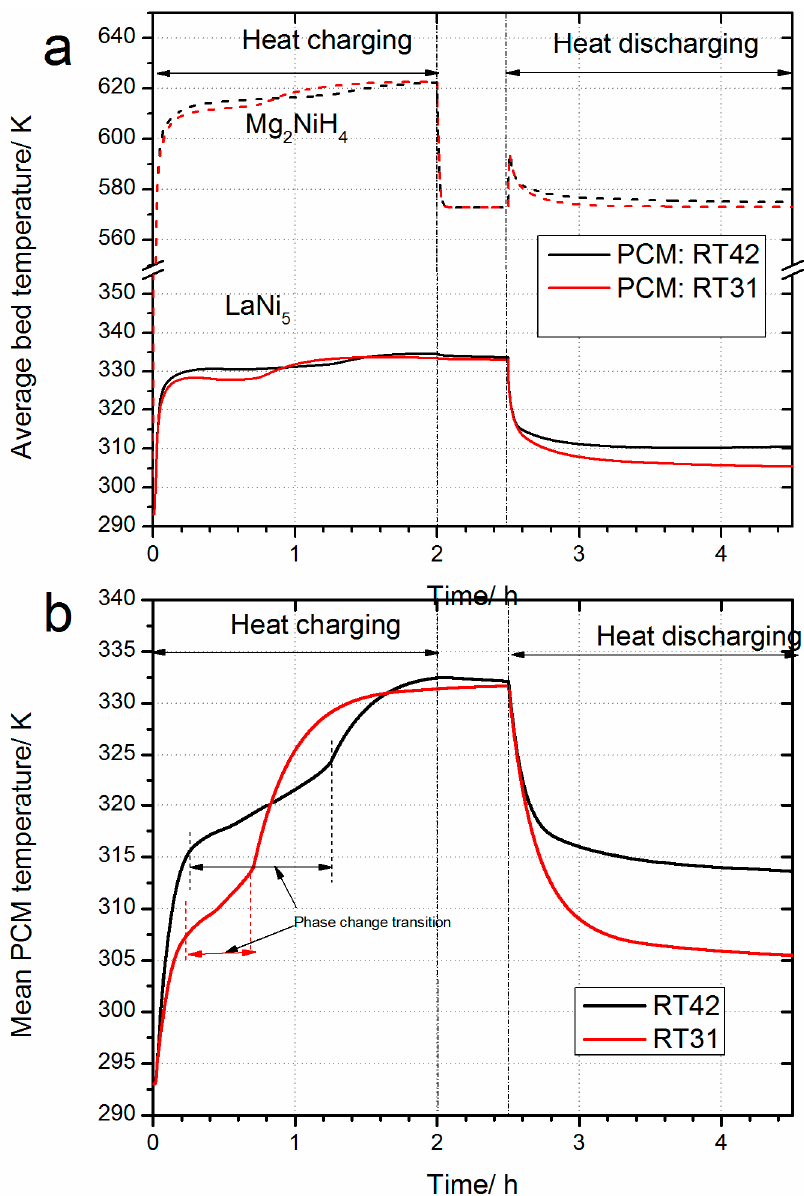
Figure 8. The influence of PCM melting point on the temporal profile of: ( a ) average beds temperature, ( b ) PCM mean temperature.